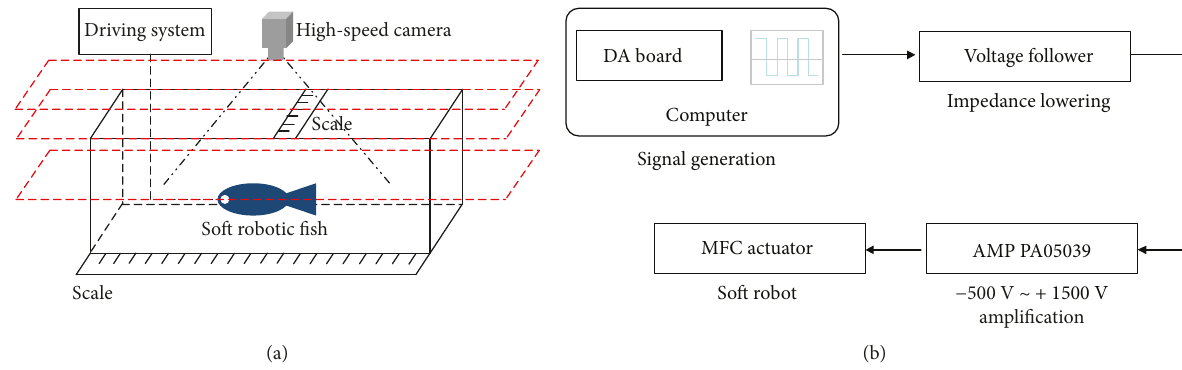
Figure 8: Experiment of robot prototype. (a) Experimental platform. (b) Driving system of the robot prototype. Table 5: Bending mode frequencies of the new soft robot prototype in the fl uid.